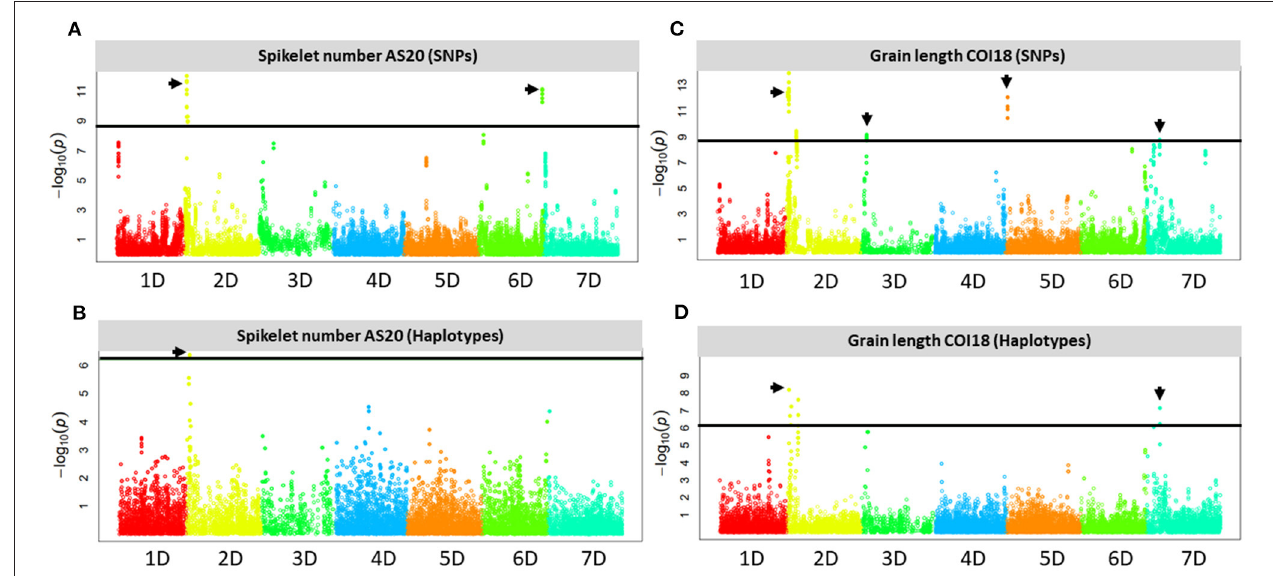
FIGURE 4 | Manhattan plots showing the D genome loci with SNPs and haplotypes that are significantly associated with SNS at Ashland in 2020 (AS20) under rainfed conditions (A,B) and GL at Colby in 2018 (COI18) under irrigated conditions (C,D) in the Aegilops tauschii introgression population. The horizontal solid black line shows a threshold of 0.05 significance level for Bonferroni correction, the black arrowheads indicate the SNPs, and haplotypes above the